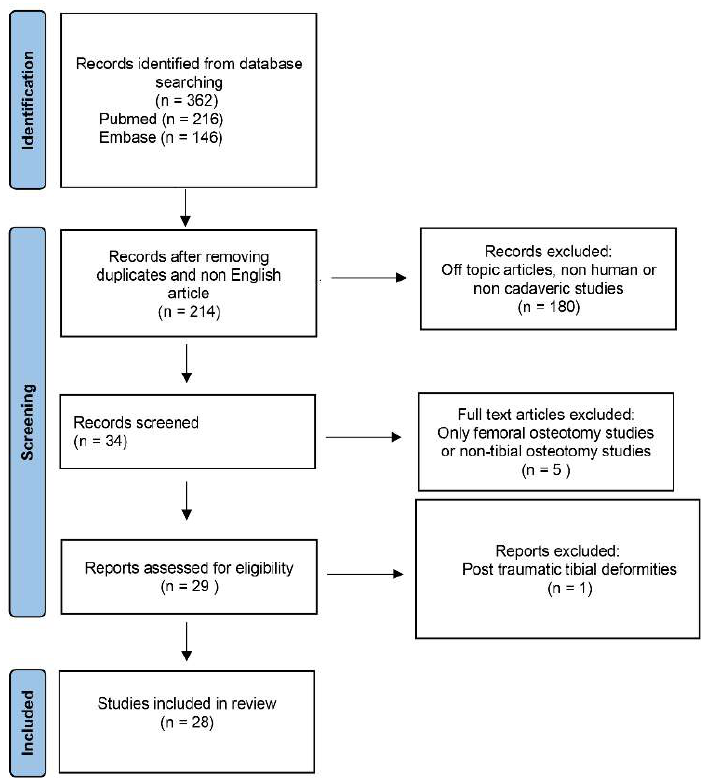
Figure 1. PRISMA flow diagram .